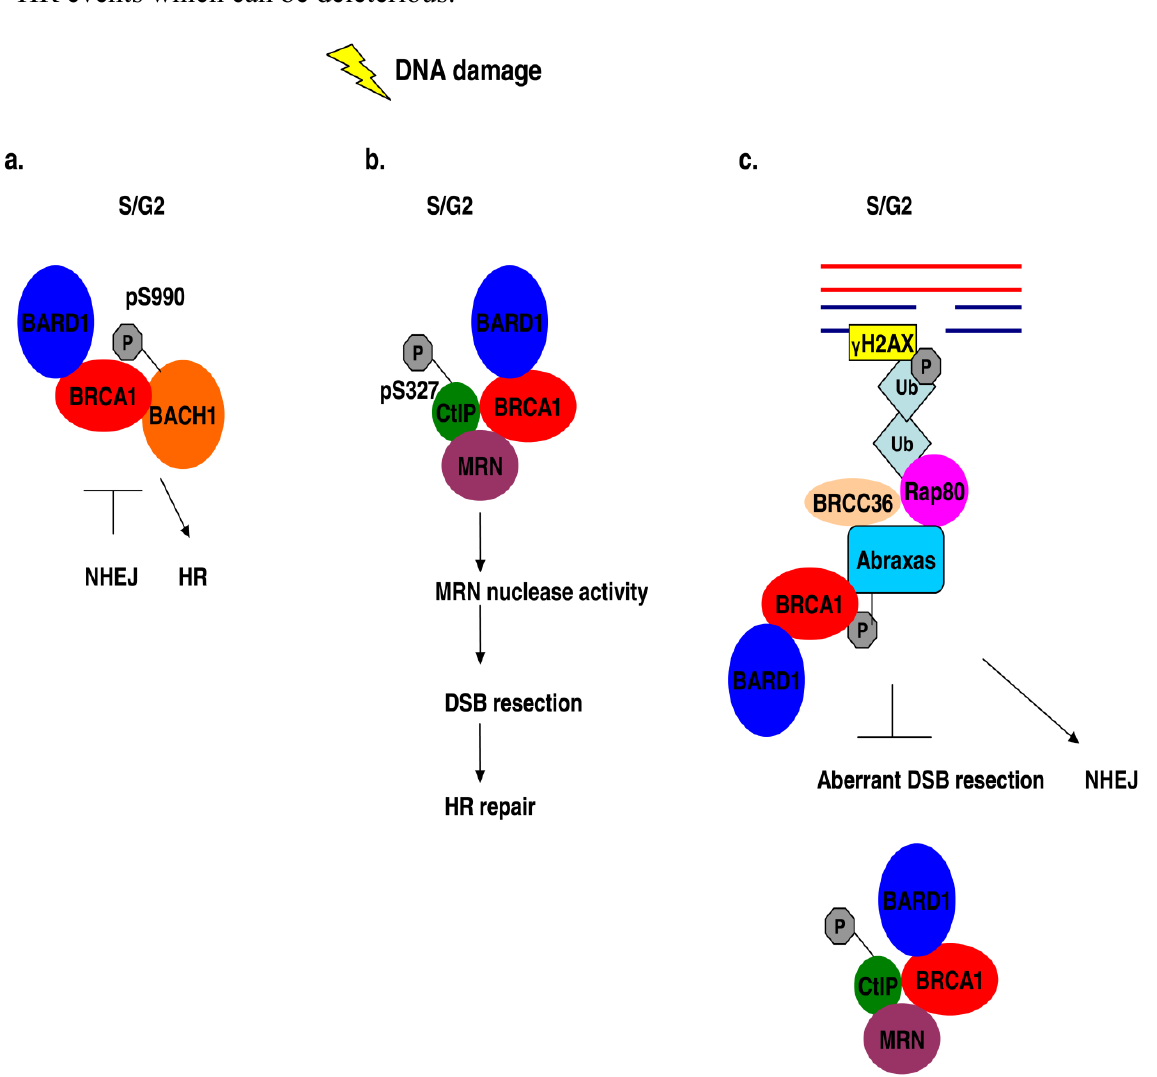
Figure 4. BRCA1 association with different protein complexes during the S/G2 phase of the cell cycle regulates HR repair mechanisms in response to DNA damage. ( a ) The error-prone NHEJ is inhibited by the interaction of phosphorylated BACH1 with BRCA1 in S/G2 damaged cells and HR is promoted instead. ( b ) DNA damage in S/G2 cells induces the association of phosphorylated CtIP with BRCA1 and MRN, thus enhancing the nuclease activity of the MRN complex of proteins which enables efficient HR. ( c ) The interaction of Rap80 with BRCA1 in S/G2 cells following DNA damage blocks aberrant HR events which can be